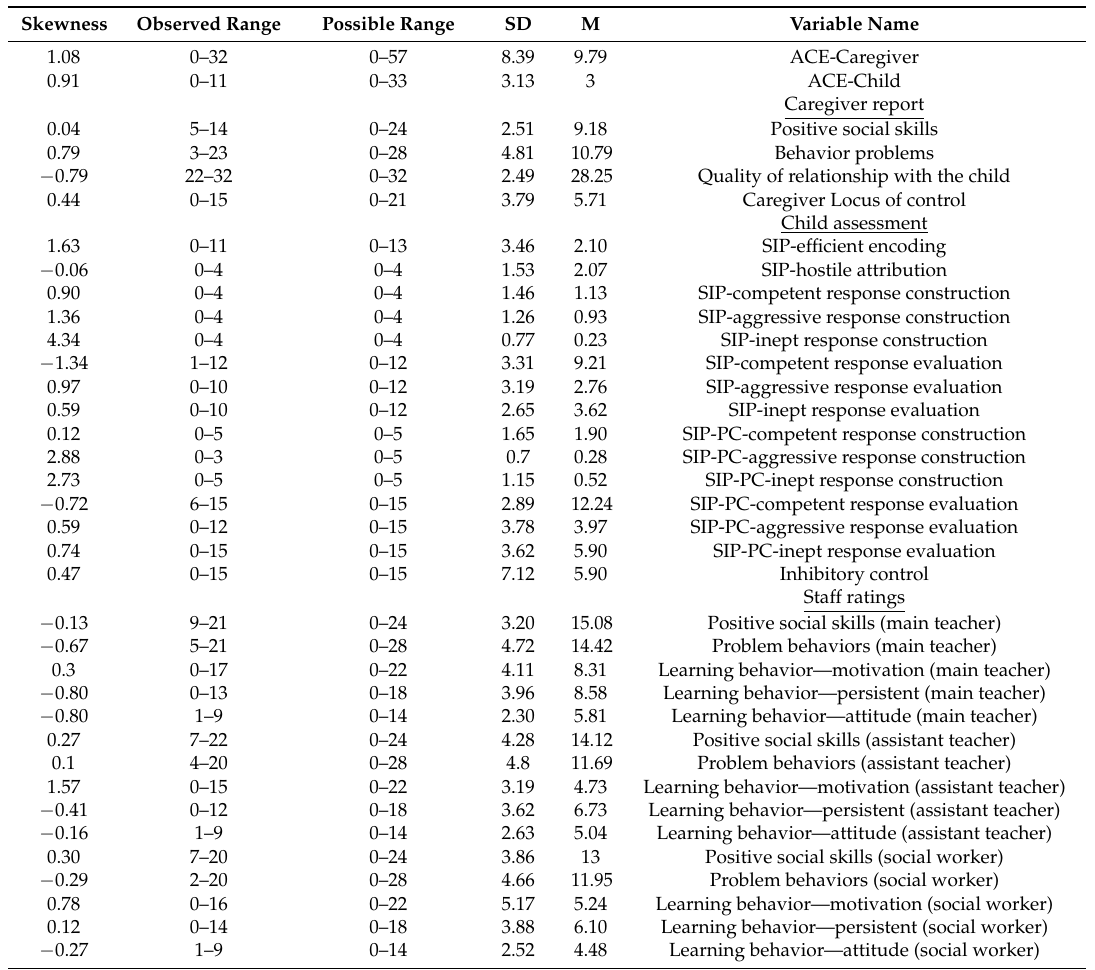
Table A1. Descriptive statistics for all study